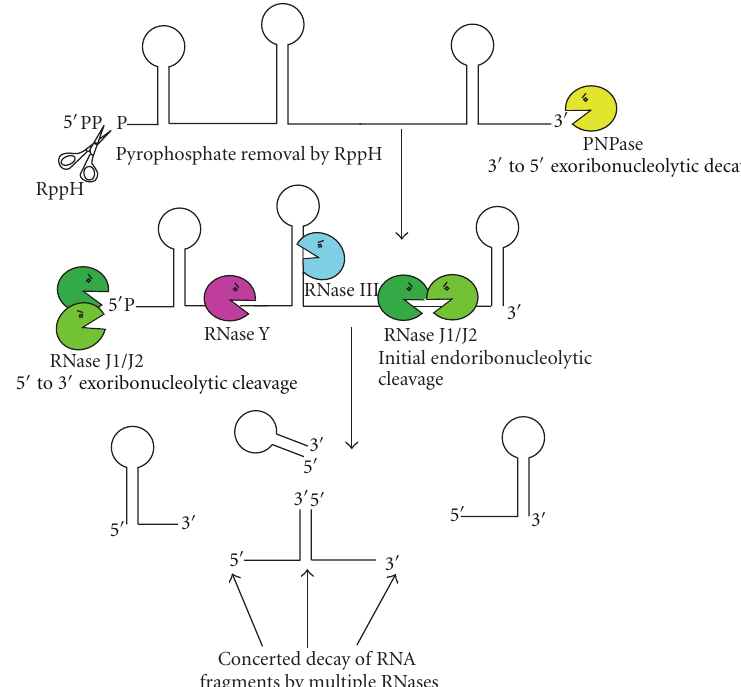
Figure 1: Diagram illustrating RNA decay by the RNases involved in virulence in Gram-positive bacteria. Removal of pyrophosphate from the 5 (cid:2) end of mRNA by RppH is represented by the scissors. The degradation of RNA via the 3 (cid:2) end is mediated by the 3 (cid:2) to 5 (cid:2) exoribonucleolytic activity of PNPase (in yellow). RNases J1 and J2 (in green) cleave RNA endoribonucleolytically and exoribonucleolytically in the 5 (cid:2) to 3 (cid:2) direction. RNase Y (in pink) and the dsRNA-specific RNase III (in blue) cleave RNA